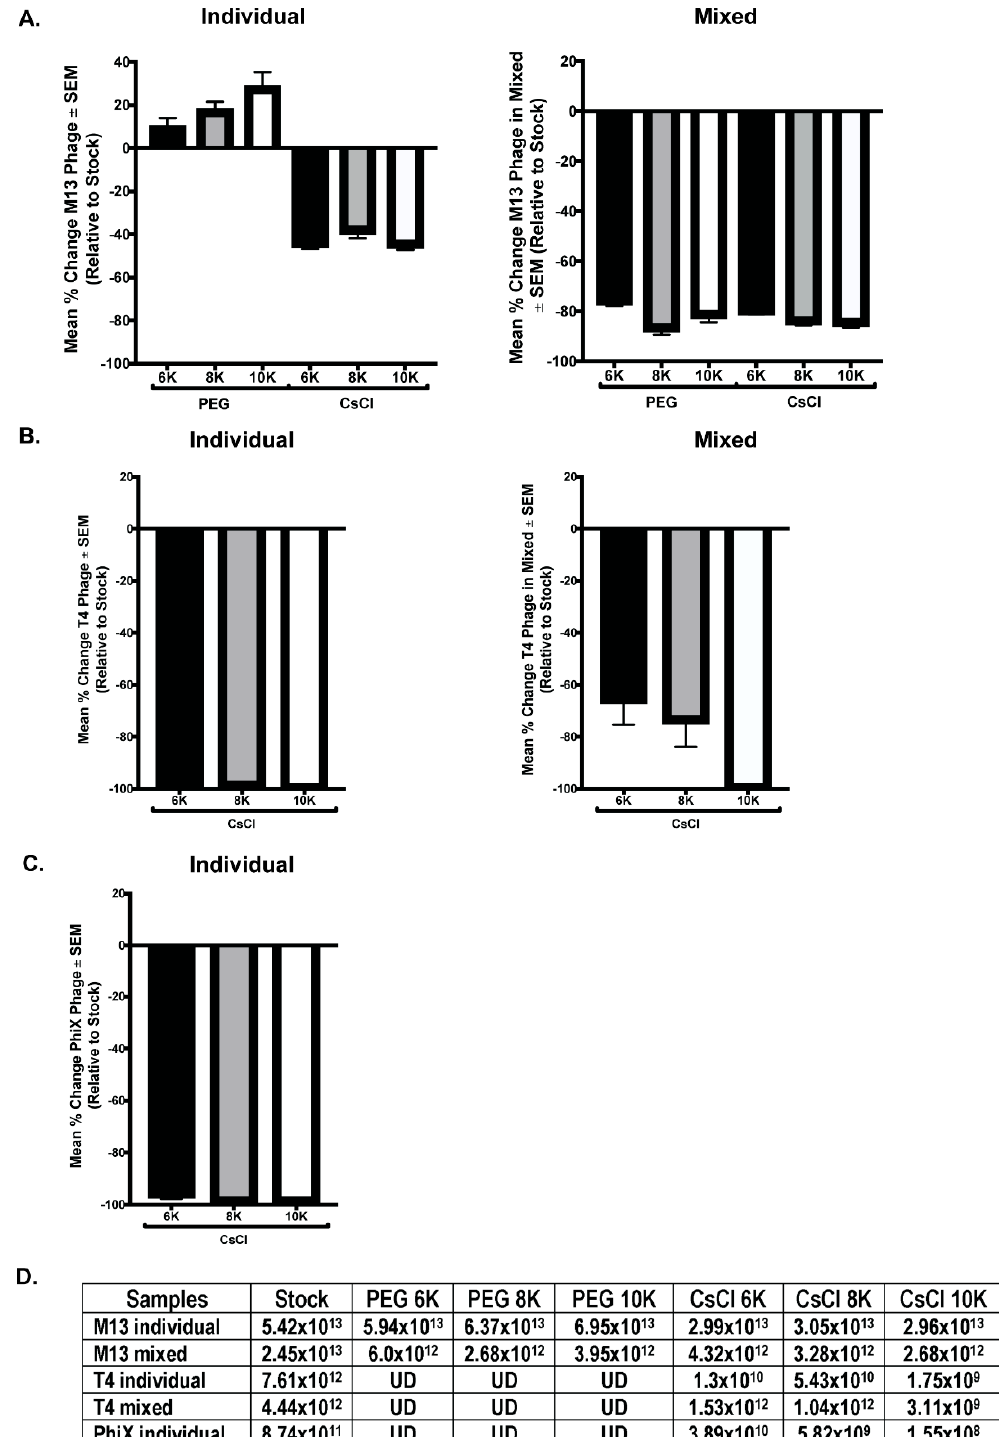
Figure 6. Selected phage numbers are significantly decreased after PEG precipitation and/or CsCl purification. Mean percent change in phage numbers as determined through qPCR quantitation of DNA is shown for the individual (left column) and mixed (right column) phage samples for ( A ) M13, ( B ) T4, and ( C ) Φ X. ( D ) The average numbers of phage/mL calculated for each sample set show consistent and significant decrease in phage after PEG precipitation (T4, Φ X but not M13) and CsCl purification when compared to stock. UD = undetectable.